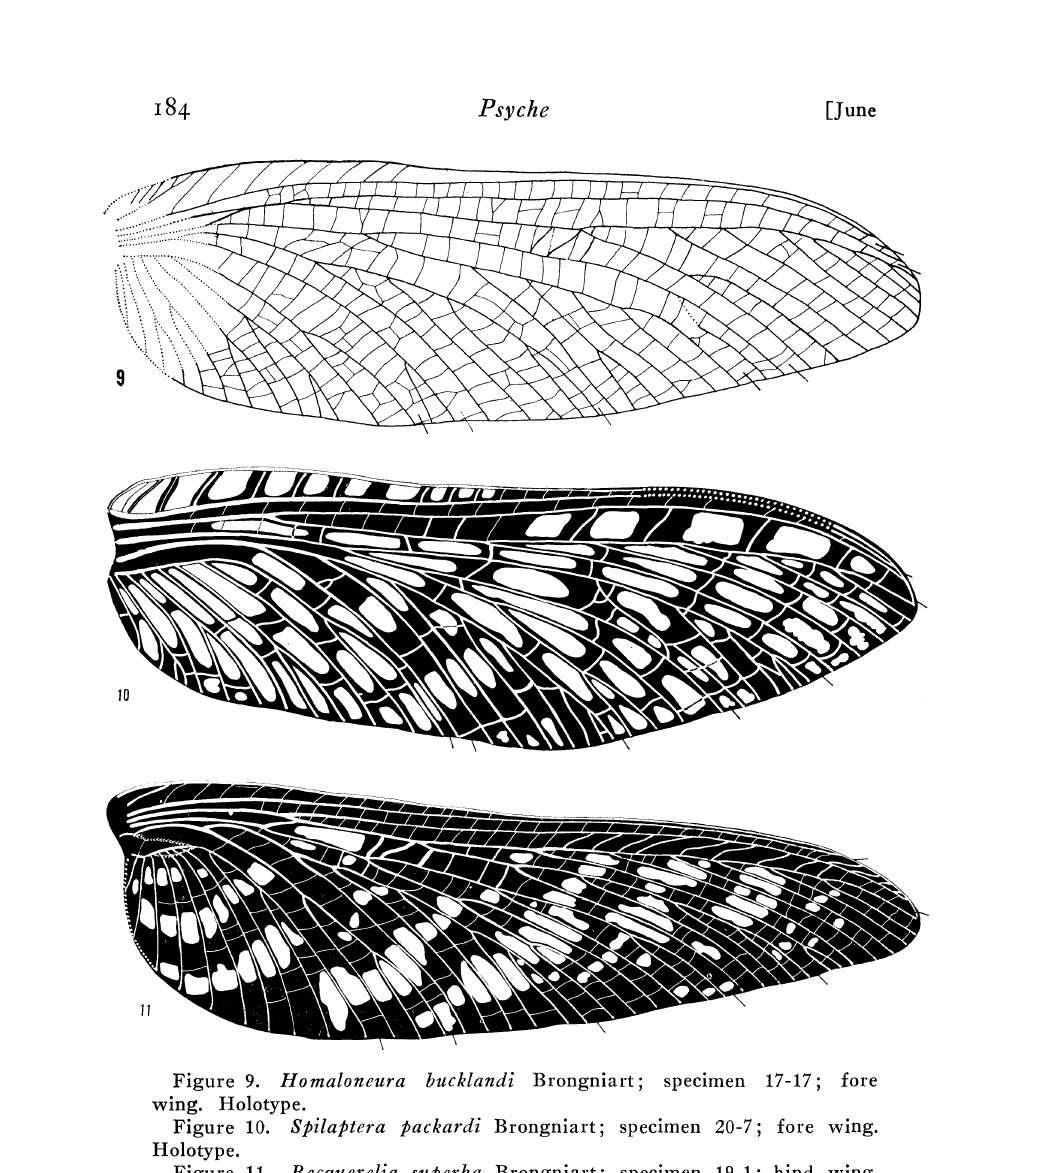
Figure 9. Homaloneura bucklandi Brongniart; specimen 17-17; fore wing. Holotype. Figure 10. Spilaptera packardi Brongniart; specimen 20-7; fore wing. Holotype. Figure 11. Becquerelia superba Brongniart; specimen 19-1; hind wing.